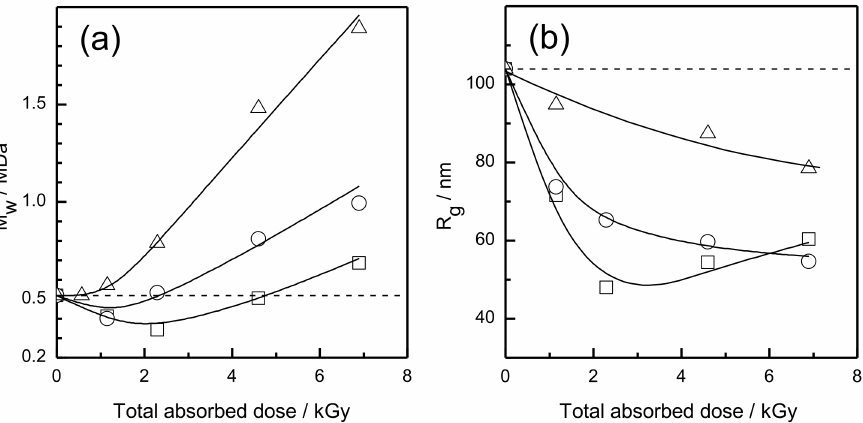
Figure 14. Changes in the weight-average molecular weight, M w ( a ), and in the radius of gyration, R g ( b ) of PAA molecules in the course of nanogel synthesis as a function of total absorbed dose (1.15 kGy corresponds to a single electron pulse) for samples of various PAA concentrations: (cid:3)